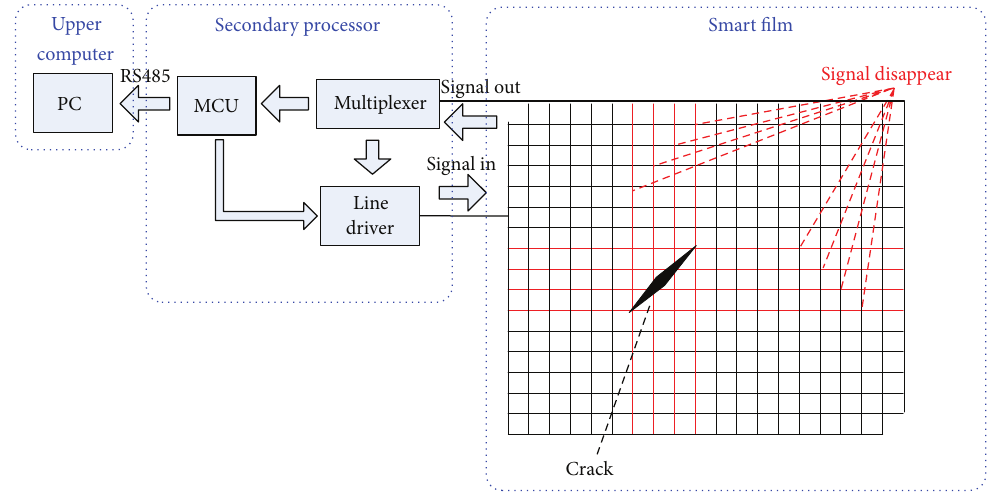
Figure 1: Schematic of smart film monitoring